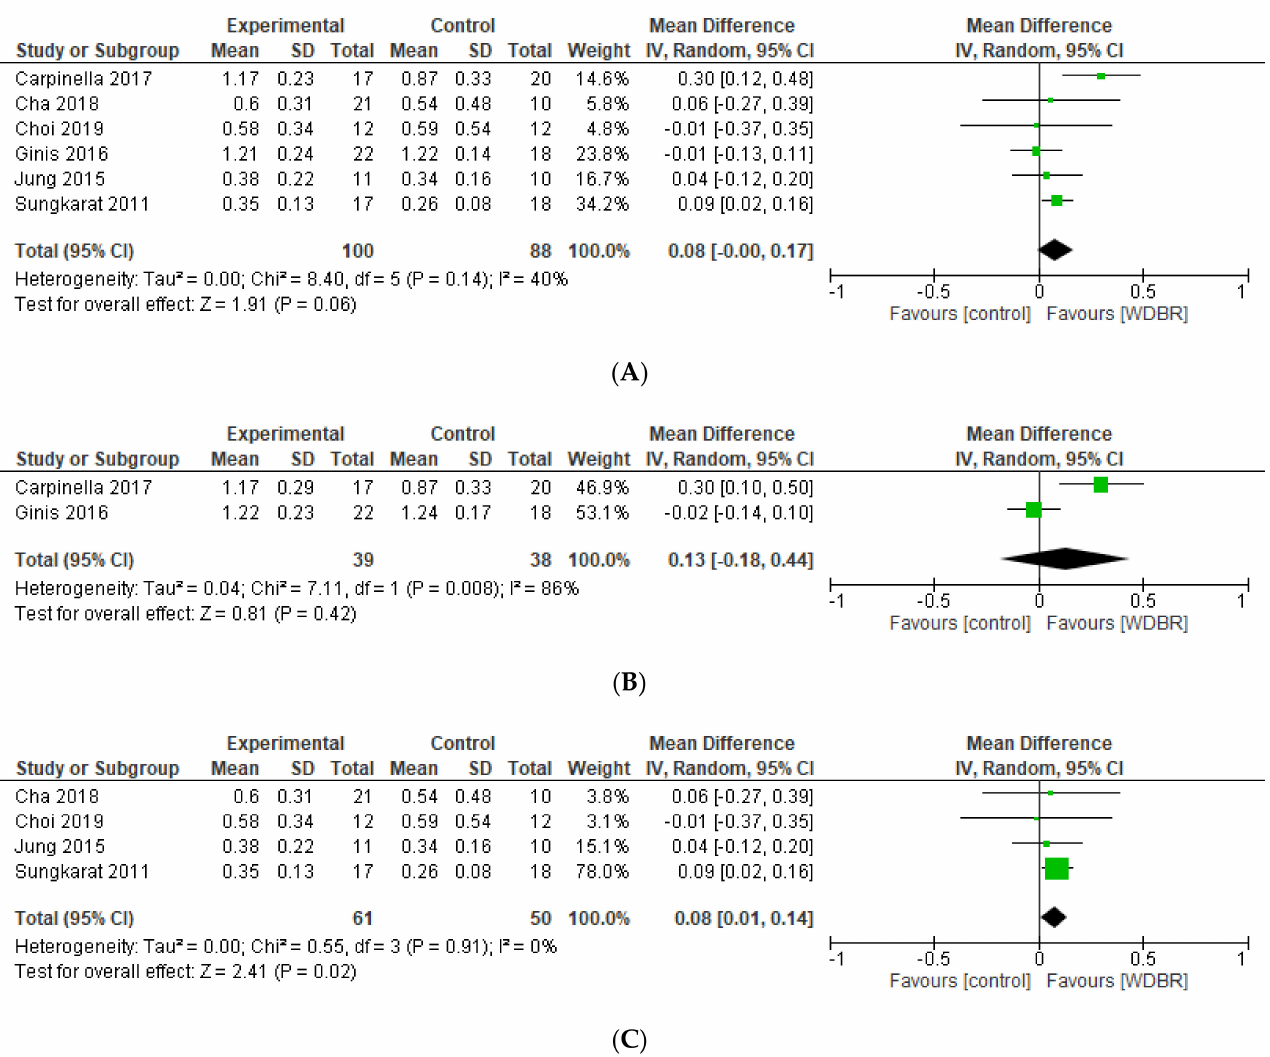
Figure 6. Forest plots of studies comparing add-on WDBR versus control. ( A ) Overall effect of WDBR versus control at postassessment on gait speed. ( B ) Overall effect of WDBR versus control at follow-up assessment on gait speed. ( C ) Subgroup analysis: effect of WDBR (pressure sensors with auditory biofeedback) versus control at postassessment on gait